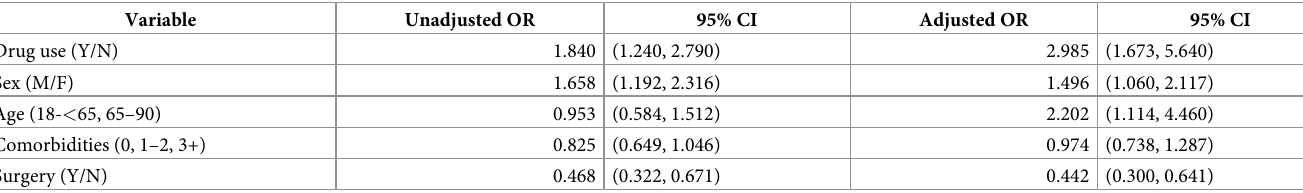
in DU-IE. Findings also show drug use was an independent predictor of discharge against medical advice/in-hospital mortality. There was a significant burden of care in patients with DU-IE who more commonly underwent cardiac surgery and received psychiatric services/ consultations compared with patients with non-DU-IE. Multidisciplinary care involving three or more consultative services was common across the entire study population reflecting the serious nature of an IE diagnosis. This study supports other recent reports of increases in IE cases, particularly among people who inject drugs [5–7, 14]. While the increase in DU-IE cases was steep, there was also a grad- ual increase in the non-DU-IE cases. Findings from our study show that patients with non- DU-IE were significantly older (median age 64 years), and over half had three of more comor- bidities such as type 2 Diabetes and coronary artery disease. Previous studies have also demon- strated an overall increasing incidence of IE, including among the non-drug-use associated patients [5, 15]. However, our IE population had a higher proportion of DU-IE cases (71%) than that reported for other regions of the U.S. Data from the U.S. National Inpatient Sample (NIS) indi- cated that DU-IE cases accounted for up to 23.5% of IE cases during January 2010 –August 2015 [16], while a report from North Carolina indicated that DU-IE cases accounted for only 11% of IE cases during 2007–2017 [5]. The high proportion of DU-IE cases in our sample may Table 5. Multivariable logistic regression: Discharge against medical advice/in-hospital mortality vs. discharge alive. Variable Unadjusted OR 95% CI Adjusted